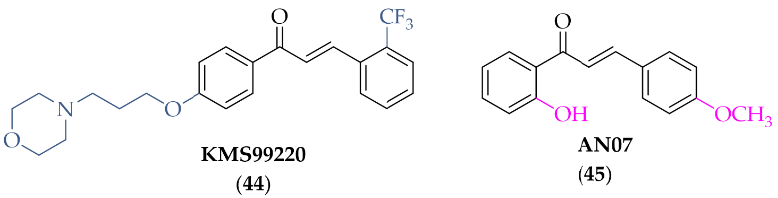
Figure 34. Chemical structure of KMS99220 ( 44 ) and AN07 ( 45 ) [77 –